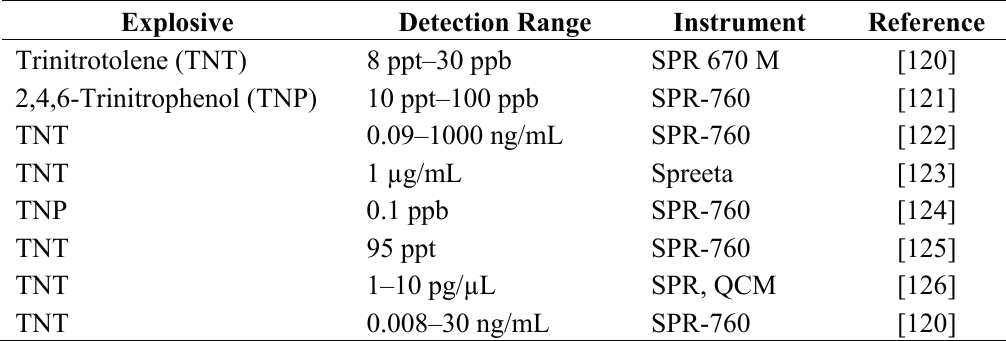
Table 3. SPR biosensors for explosive detection.